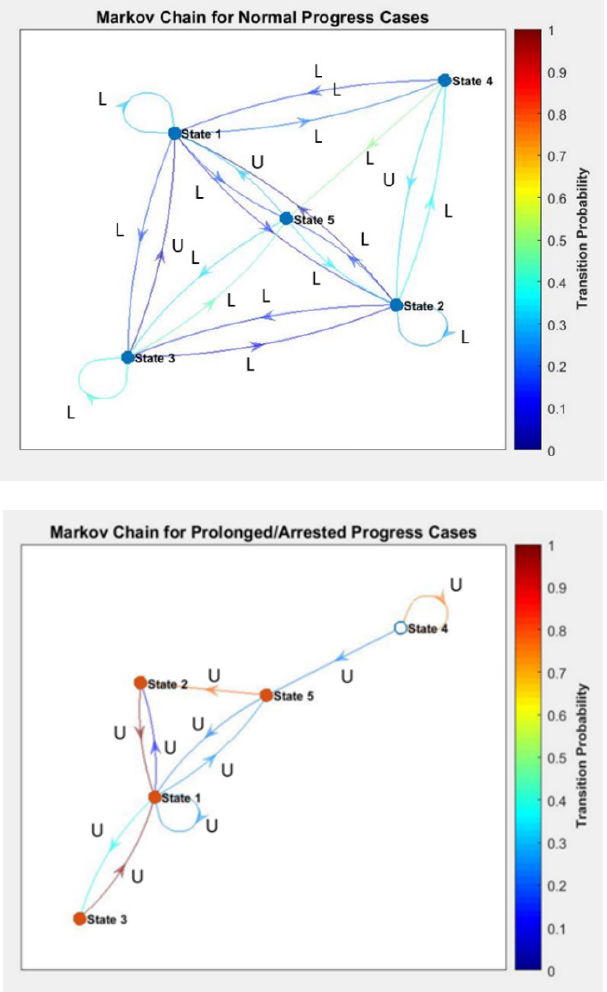
Fig. 5: Representation of the Markov chain correlation coefficients and the dominance of the uterine segment associated with them.